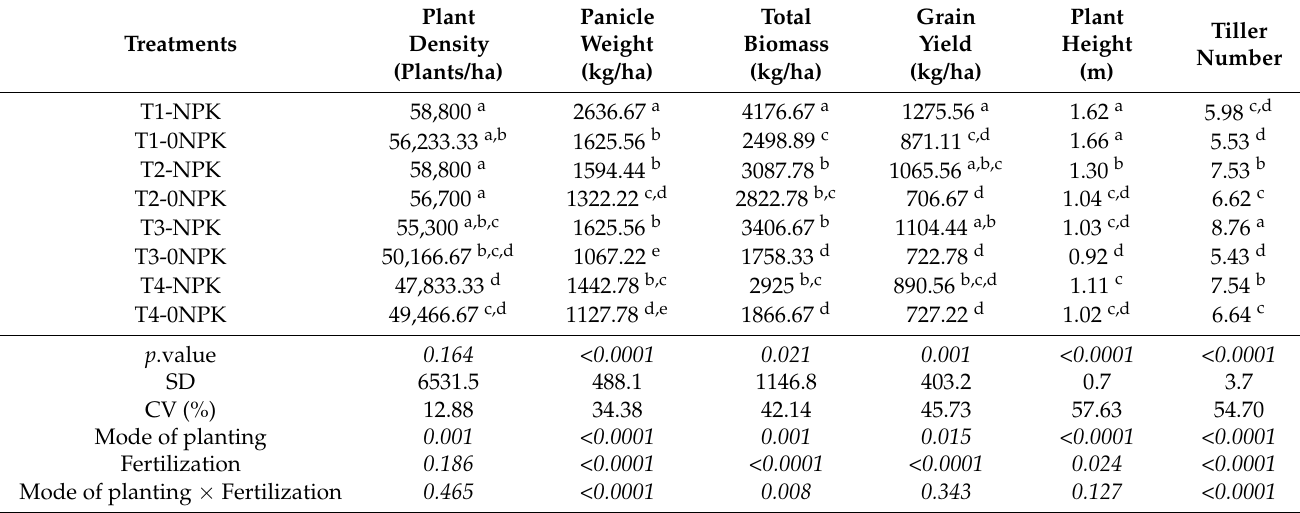
Table 3. Effects of mode of planting, fertilization, and their interactions on plant height, tiller number, and yield-related